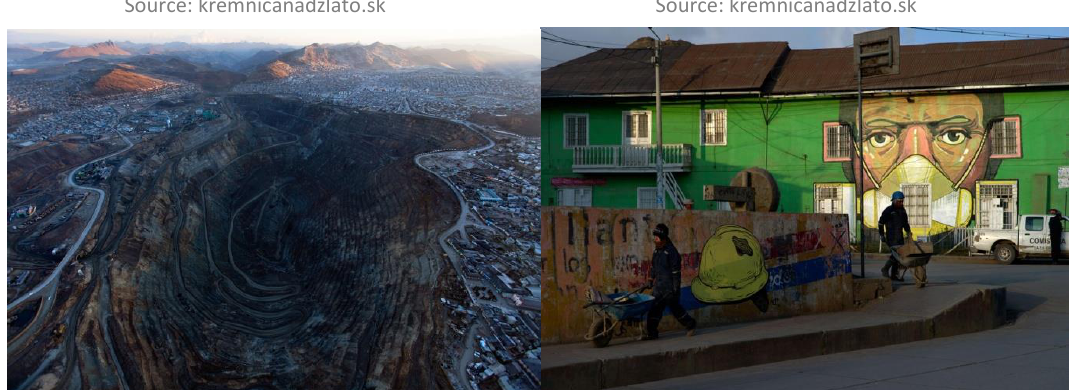
Figure 17: Cerro de Pasco, Peru, open pit Figure 18: Street art, Cerro de Pasco, Peru, silver mine depicting air pollution Source: Dajer,